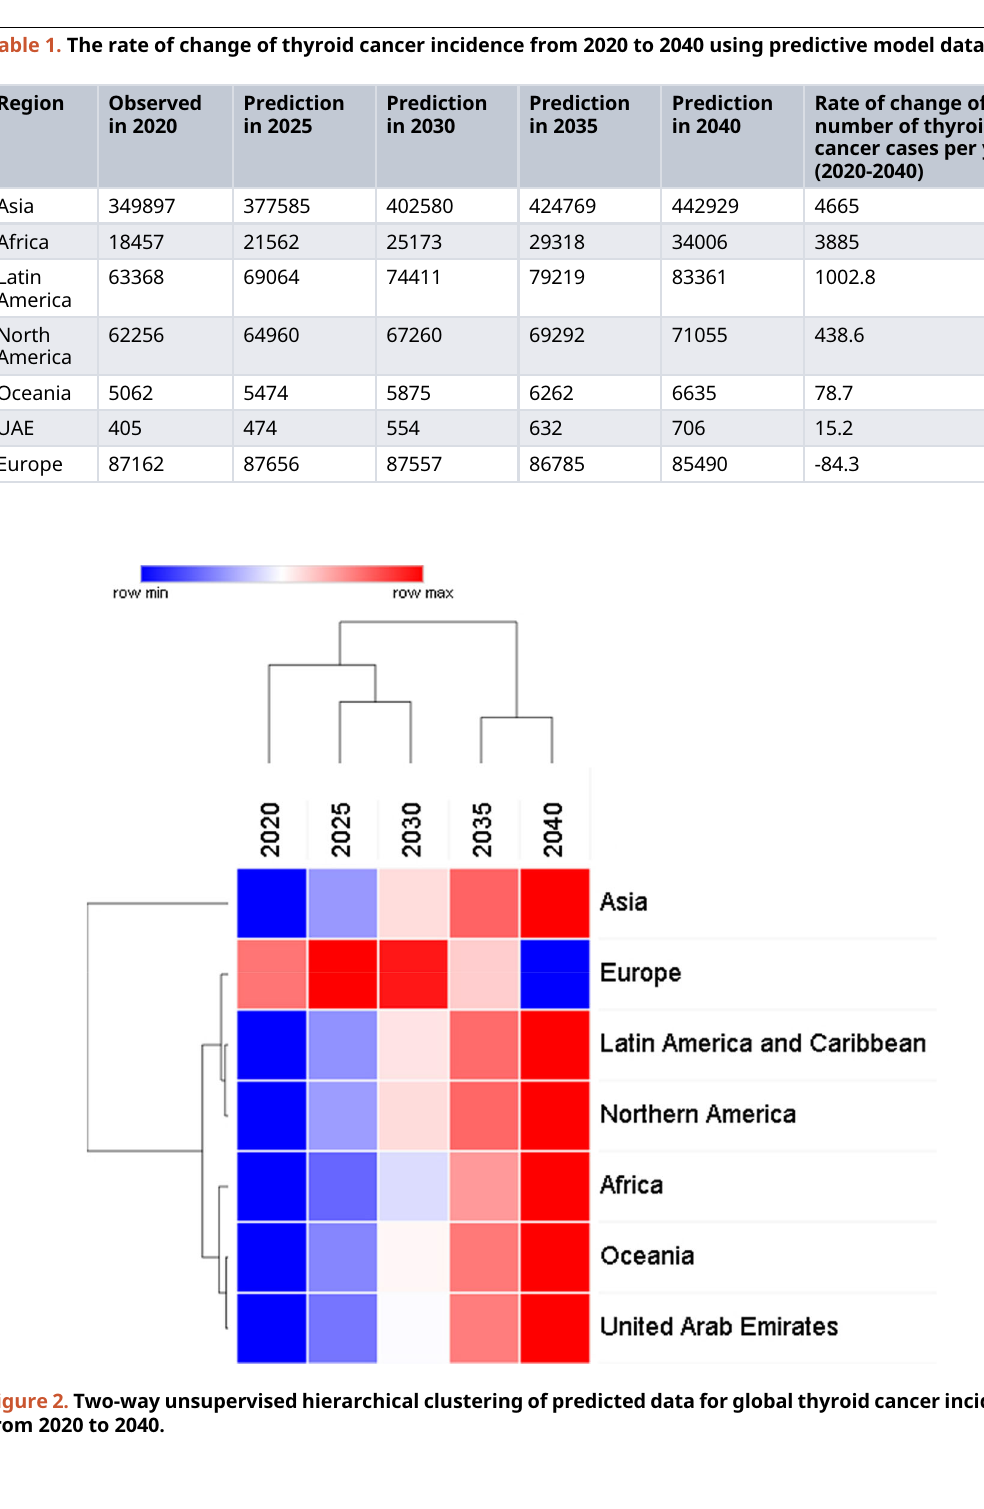
Table 1 data is generated using linear regression models for each population and calculating the rate of change of thyroid cancer cases per year from the gradient of the linear regression equation for each population. The data indicates that overall, the rate of increase of thyroid cancer cases is small compared to other cancers. The unsupervised hierarchical clustering in Figure 2 is based on the predictive model and shows that there is a steady increase in the number of thyroid cancer cases in all regions except in Europe where the cases increase at a faster rate than the other region until 2030 but then from 2030 to 2040 the cases will start to decrease.